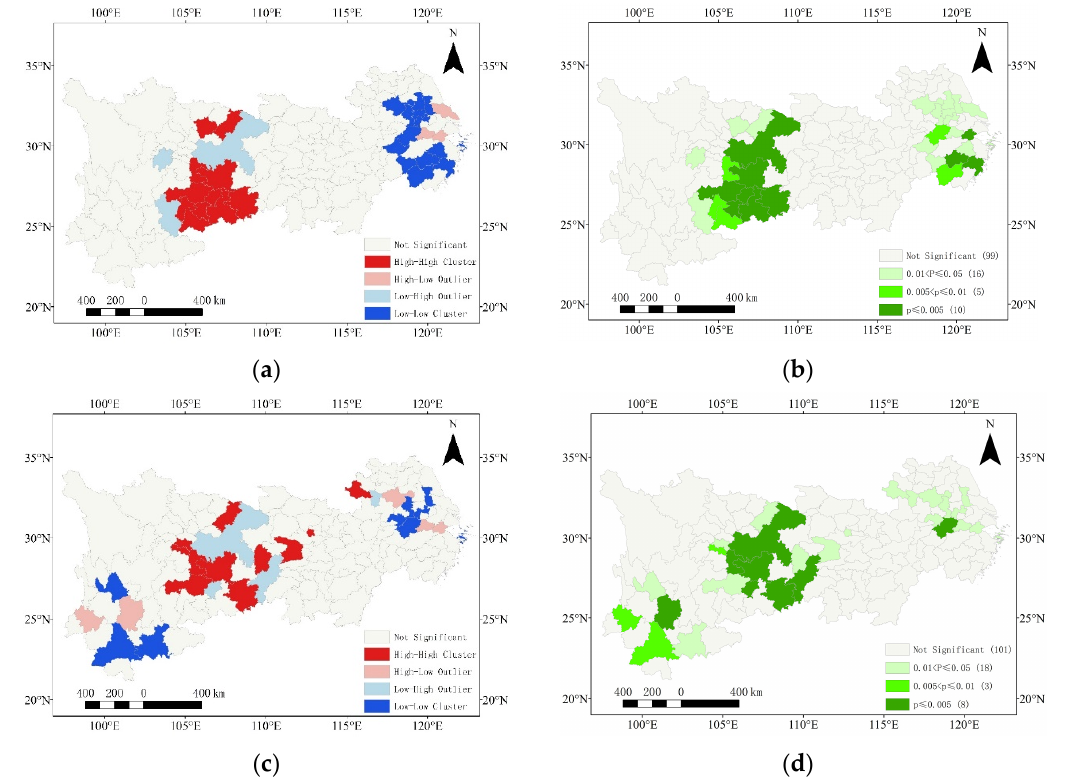
Figure 10. The autocorrelation analysis of urban growth: ( a ) LISA cluster map for urban area growth rate; ( b ) significance map for urban area growth rate; ( c ) LISA cluster map for night-time light rate; ( d ) significance map for night-time light growth rate.